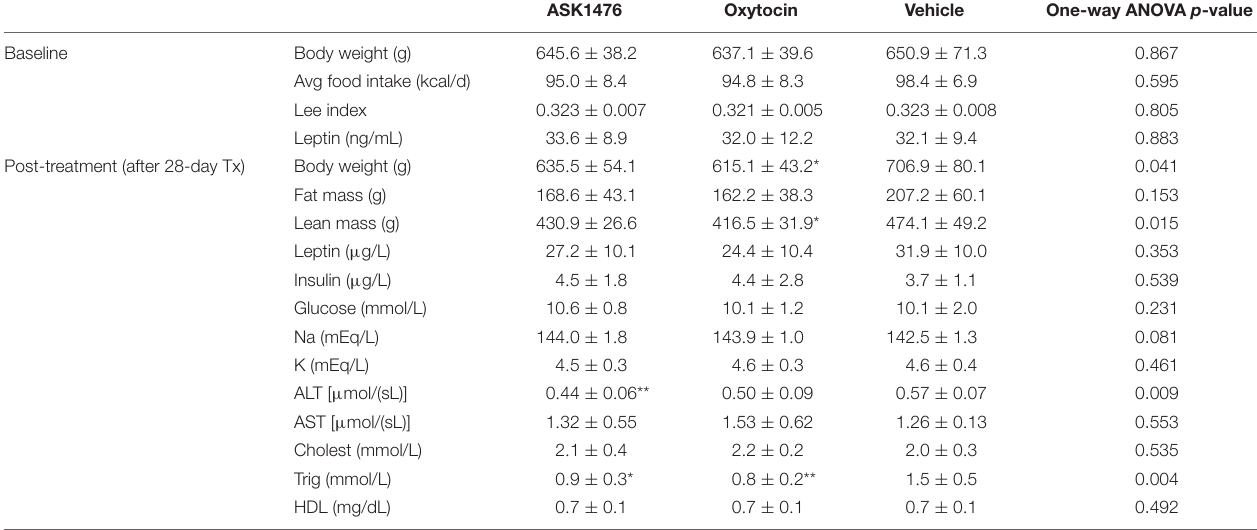
TABLE 2 | Diet induced obese (DIO) rat measurements and blood parameters before and after 28-day treatment. ASK1476